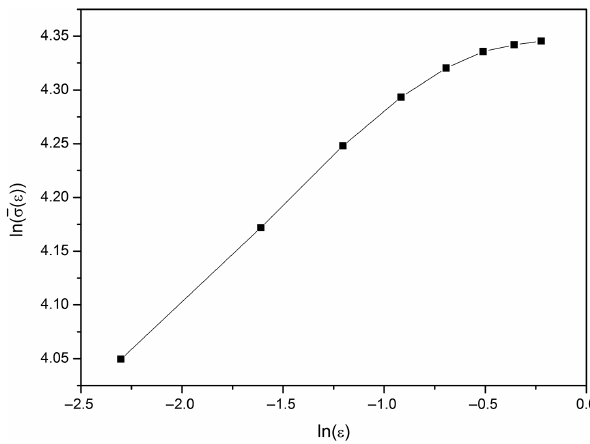
(17) Figure 6: Relationship between ln ð (cid:2) σ ð ε ÞÞ and ln ð ε Þ